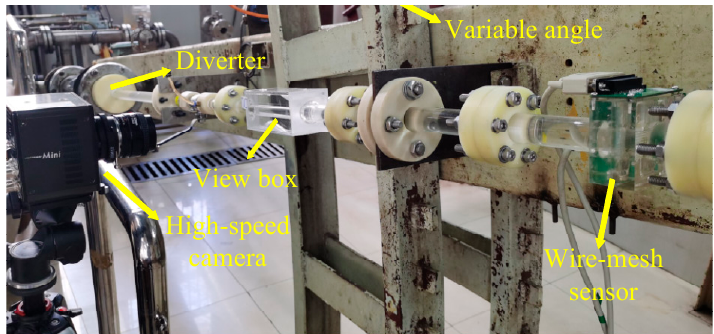
Figure 5. The experimental setup for horizontal and inclined oil–water flows.